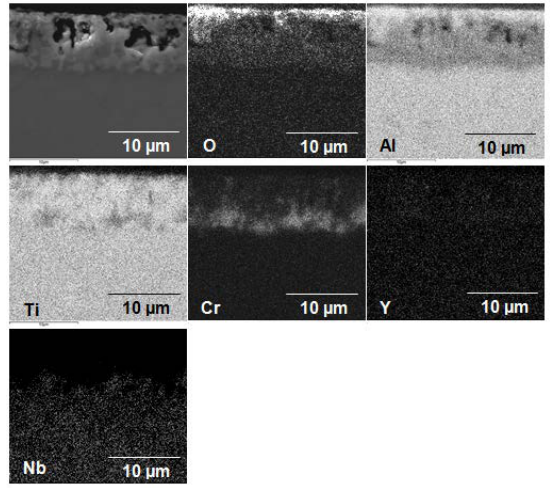
Figure 6. Digimaps of TiAlCrY coated Ti45Al8Nb after 500 hours oxidation at 850 ◦ C